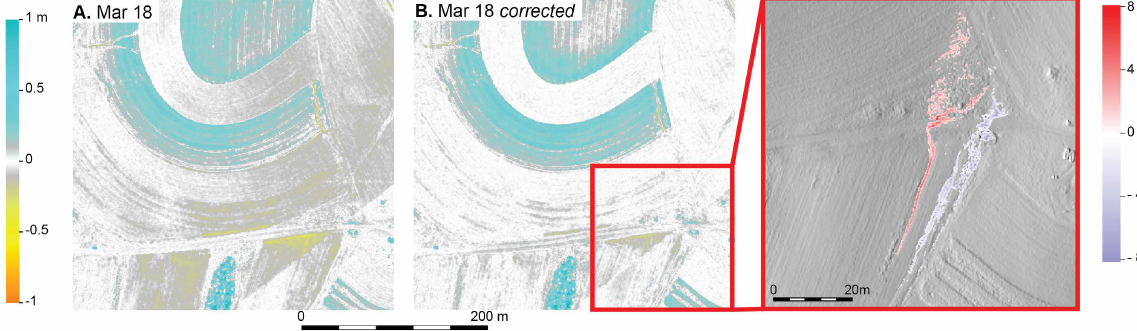
Figure 4: Differences in elevation between the lidar and sUAS based terrain models from the March flight. Figure A shows in blue areas where sUAS based DSM is higher than lidar. In B we show the difference after applying the shift correction and the inset shows the differences higher than 1 cm of overland flow depth simulated on these two